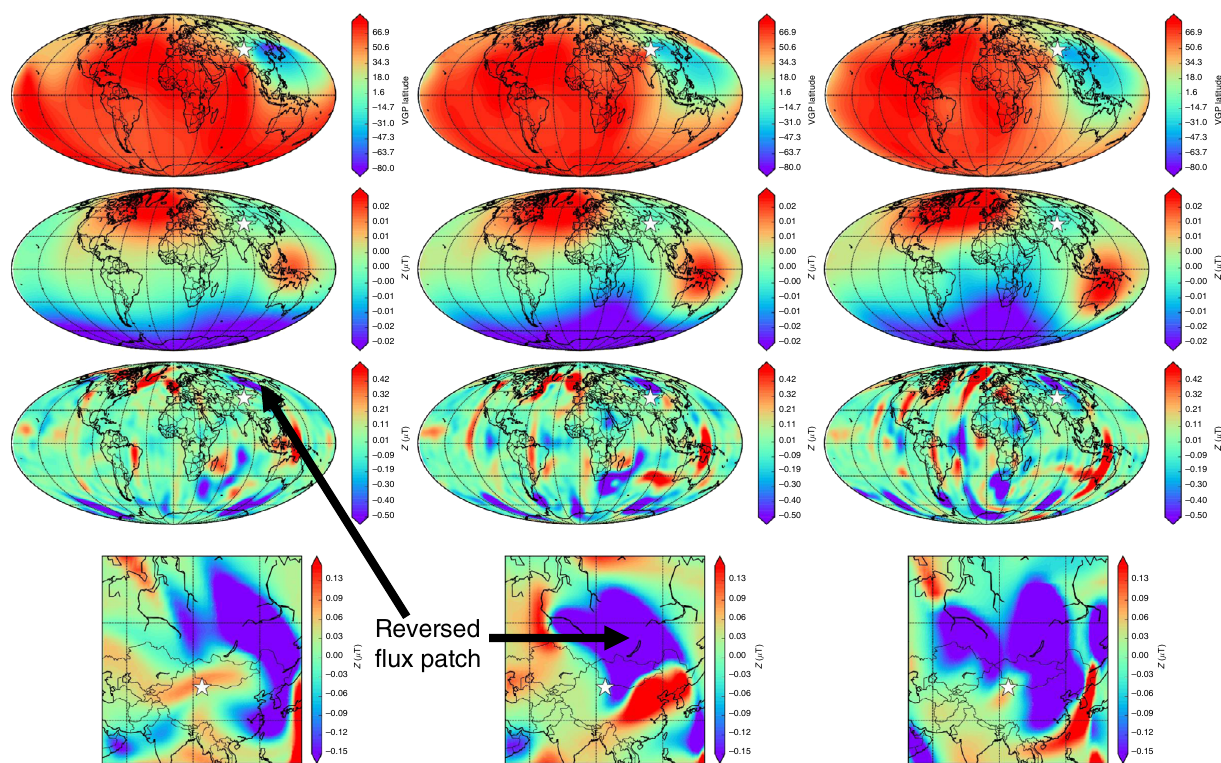
Fig. 5 Evolution of an extreme change in the VGP position, ^P V , for the simulation with E = 5 × 10 − 4 , Pm = 5, Ra = 400 and Rm = 257. Rows show the VGP latitude λ V , vertical component of the magnetic fi eld Z at Earth's surface, and at the CMB, and a local Mercator projection of the CMB fi eld around the location of maximum change (white star). Columns show times just before (left), during (centre) and just after (right) the extreme change. The extremal event arises as a reversed fl ux patch (blue) migrates from the northeast towards the point of maximum